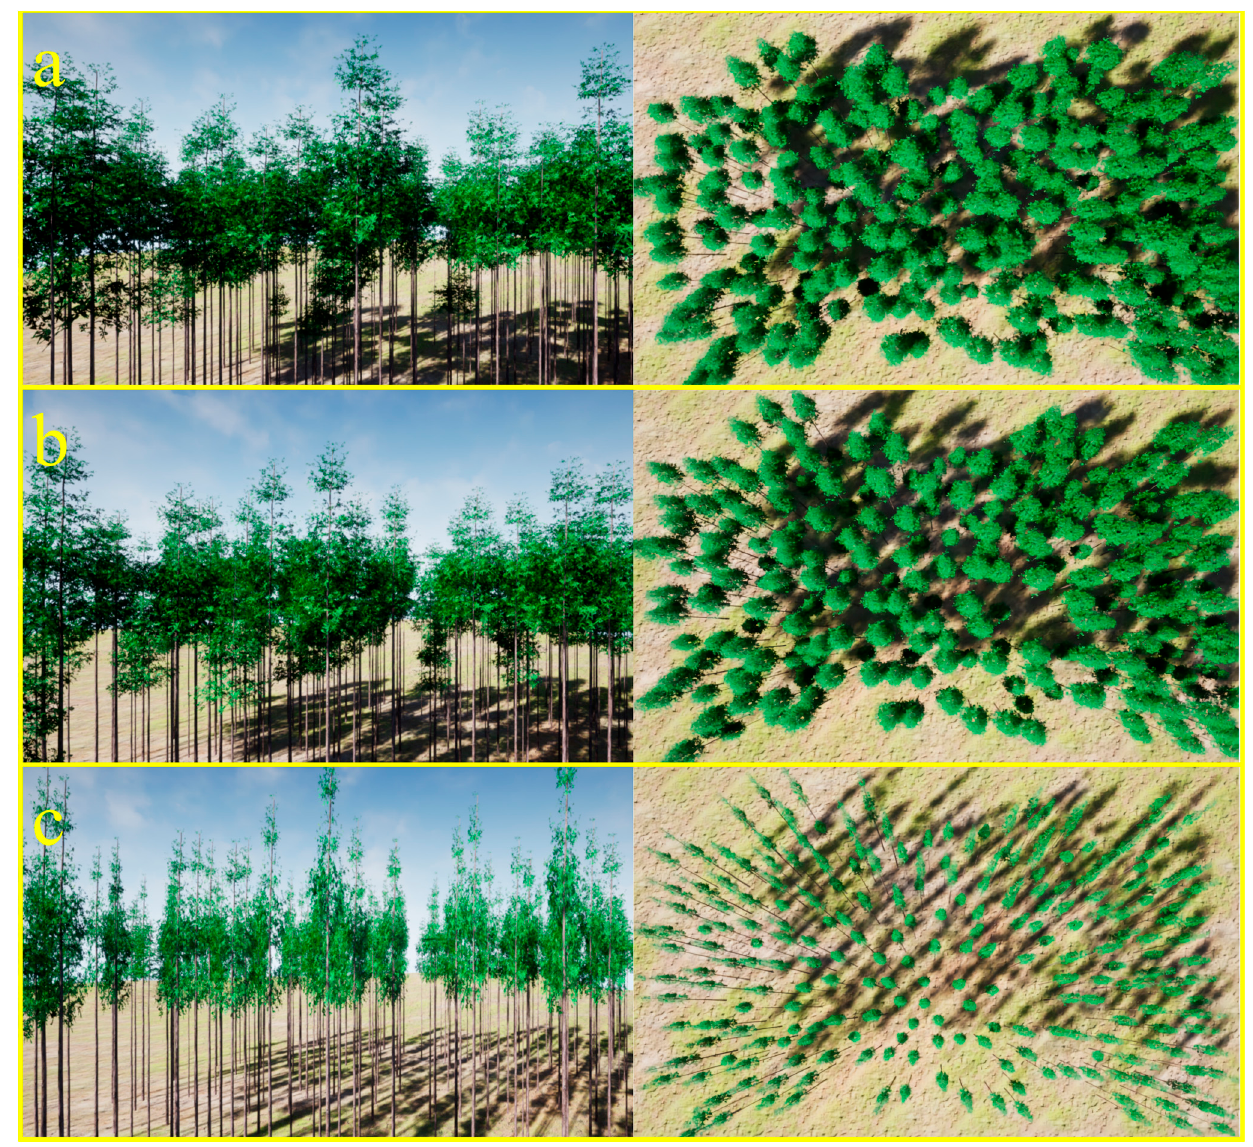
Figure 12. Results of visual simulation of 28-year-old Chinese fir stands. ( a ) Simulation from observed data; ( b ) Simulation from predicted data of CGMSS Chinese fir growth model; ( c ) Simulation from predicted data of SSU Chinese fir growth model. The left panel shows the side view observation angle of the stand visualization simulation, and the right panel shows the top view observation angle.